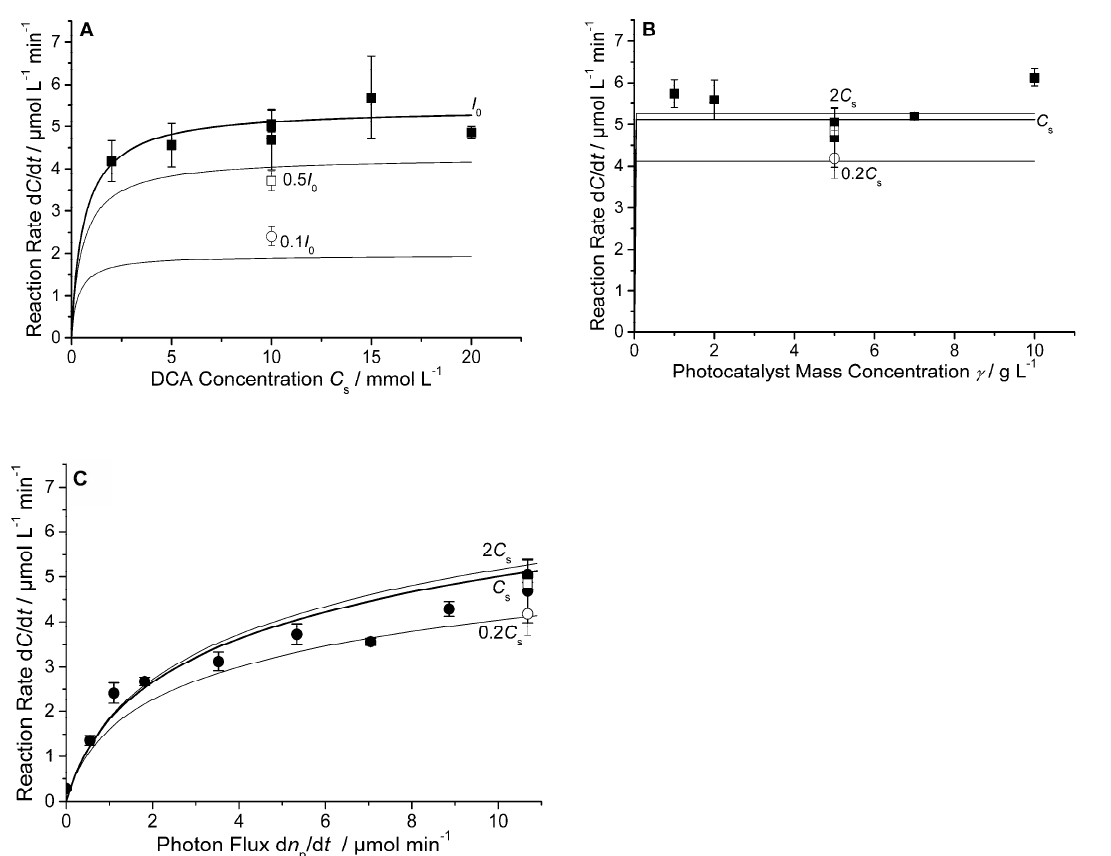
Figure 6. Comparison between calculated and experimental reaction rates. Reaction rates d C (DCA)/d t vs. ( A ) the DCA concentration C s at three photon flux densities ( I 0 = (1/A) (d n p /d t ) with A = 3.8 cm² and d n p /d t = 10.7 µmol min − ¹); ( B ) the mass concentration of the photocatalyst; and ( C ) the photon flux d n p /d t at different DCA concentrations ( C s = 10 µmol L − ¹). The symbols represent experimental data points. The lines were calculated employing Equation (19) with k r = 58.78 µmol g − ¹ min − ¹, K a = 1.023 L mmol − ¹, ε = 8.169 L cm − ¹ g − ¹, η = 51.25 × 10 − ³, and k d = 3.73 × 10 − ¹¹ µmol L − ¹ min − ¹.